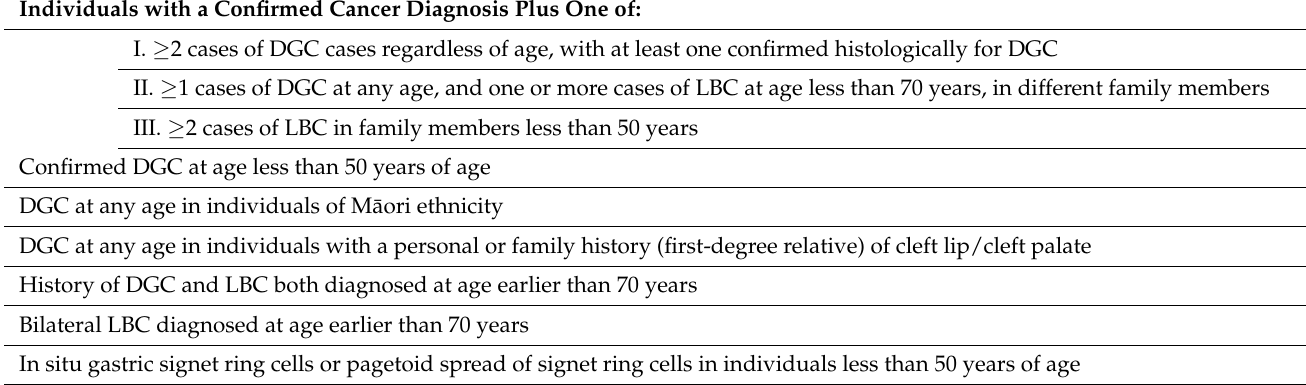
Table 2. Criteria for genetic evaluation for HDGC in affected families according to ACG 2020 updated clinical guidelines